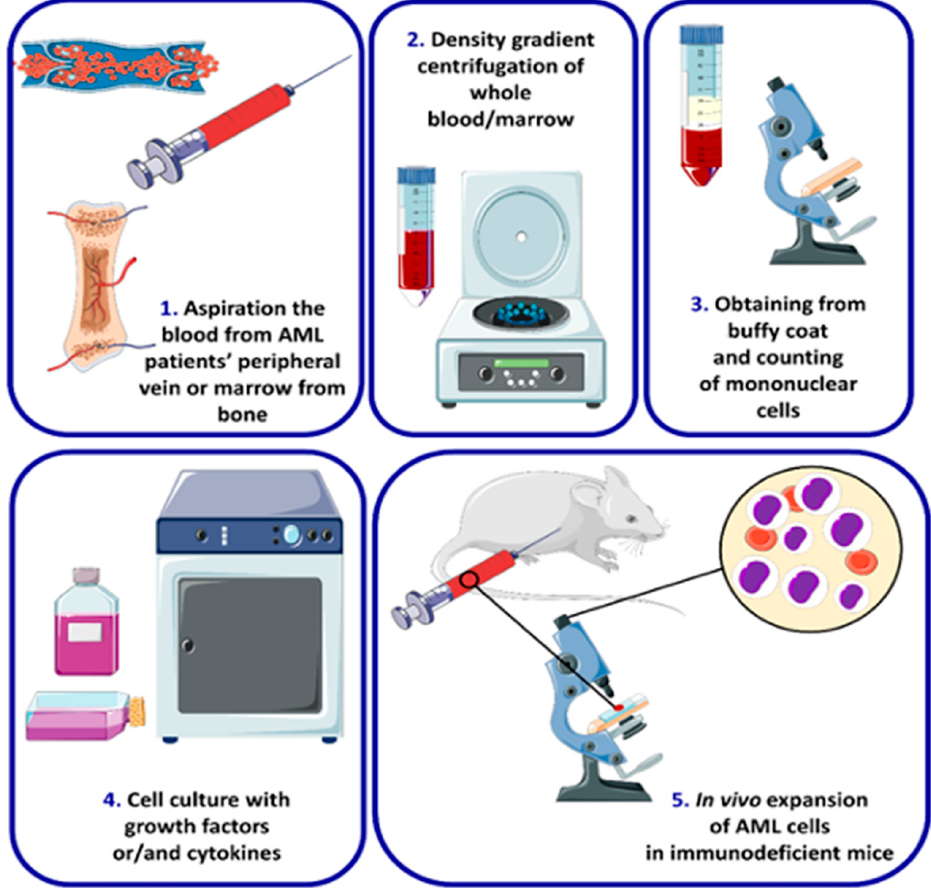
Figure 3. Simplified diagram of the procedure for the establishment of human leukemic cell lines.